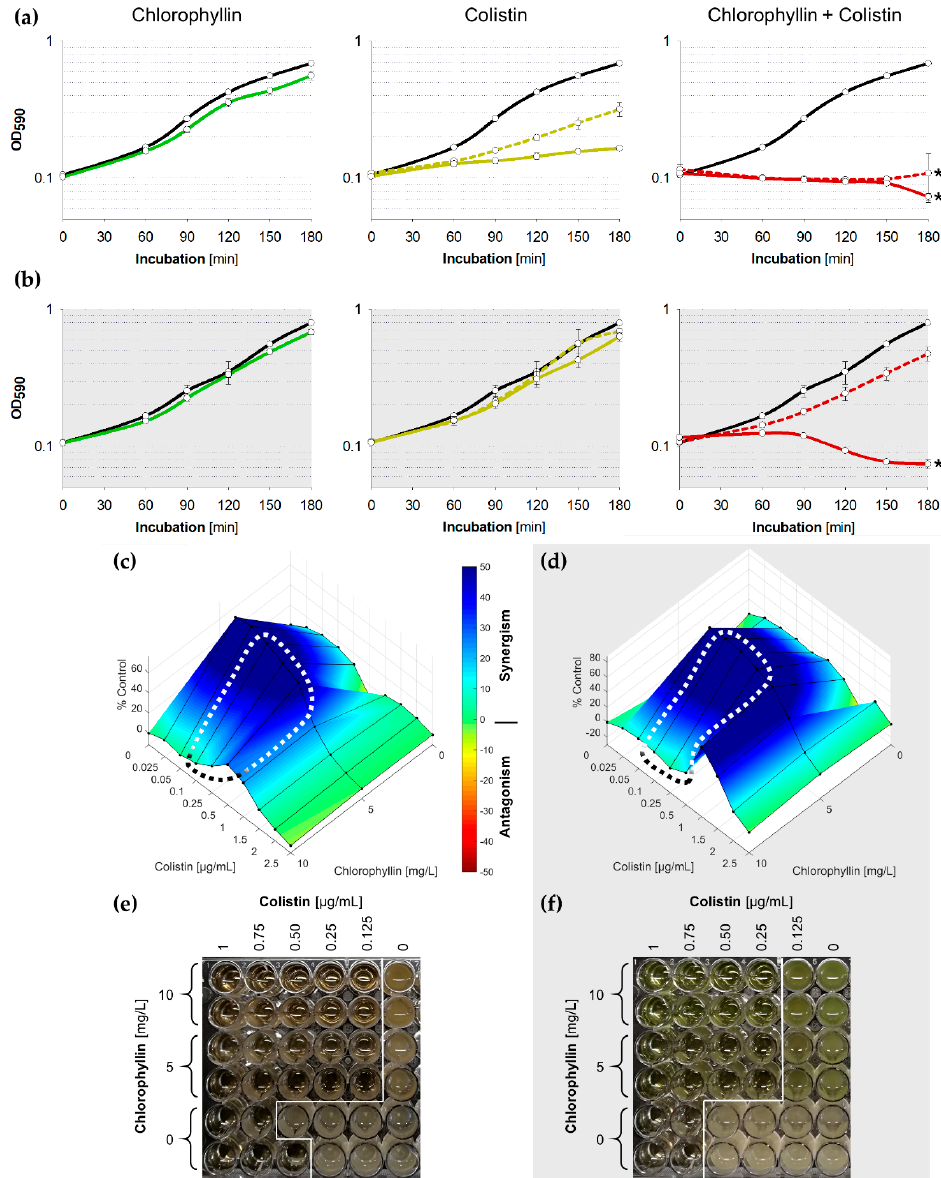
Figure 3. ( a , b ) Growth pattern of E. coli in the presence of 5 mg/L chlorophyllin (green line, first column), colistin (yellow lines, central column) and of a combination of both substances (red lines, right column). The black lines describe growth in LB without any supplementation; ( a ) cells were illuminated with a light intensity of 12 mW/cm 2 ; ( b ) cells were incubated in dark. In columns two and three, dashed lines represent cultures in LB + 0.25 µg/mL colistin, while solid lines are for cultures in LB + 0.5 µg/mL colistin. Depicted are measured values (circles) and fitted curves (lines) ± standard deviations (n = 3) showing one representative of three independent experiments. *: p < 0.05 vs. chlorophyllin-free samples; ( c , d ) Loewe synergism and antagonism for colistin/chlorophyllin combinations against the growth of E. coli as determined by the Combenefit software (Cancer Research UK, Cambridge, UK). A heat map is used to represent the level of synergy (blue color) at each concentration under ( c ) illuminated and ( d ) dark conditions. The area surrounded by dotted line includes the concentration range used for the growth curves. ( e , f ) Broth microdilution plates for minimal inhibitory concentration (MIC) determination for colistin / chlorophyllin combinations under ( e ) illuminated and ( f ) dark